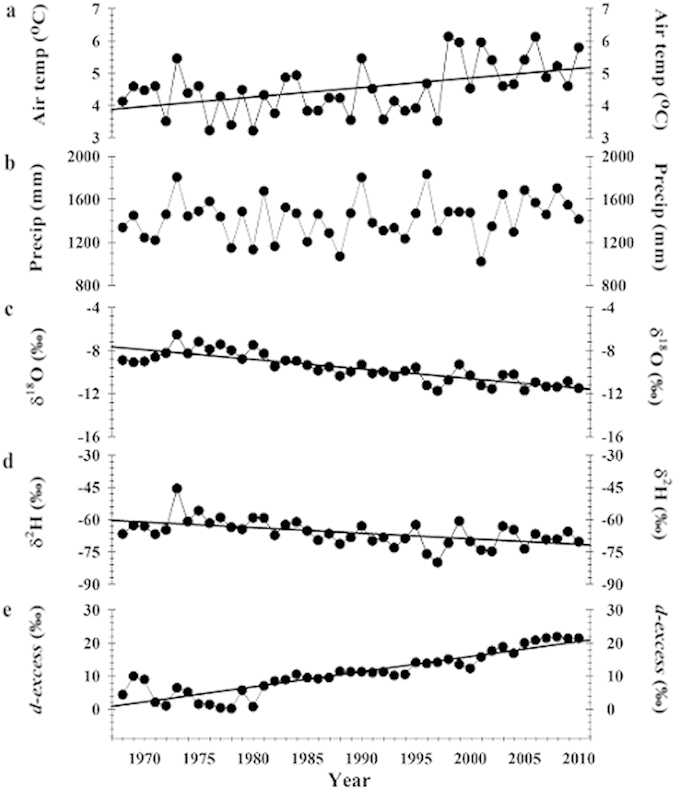
Long term annual mean values and trends in climate and precipitation isotopes at northeastern US site.(a–e) Results indicate a (a) significant increasing trend in surface air temperature (slope = 0.03 °C yr−1, P = 0.0017); (b) no significant trend in precipitation amount (slope = 2.71 mm yr−1, P = 0.25); (c) significant declines in δ18O (slope = −0.089‰ yr−1, P < 0.0001) and (d) δ2H (slope = −0.259‰ yr−1, P = 0.0002); and (e) and a significant increase in d-excess (slope = 0.46‰ yr−1, P < 0.0001).